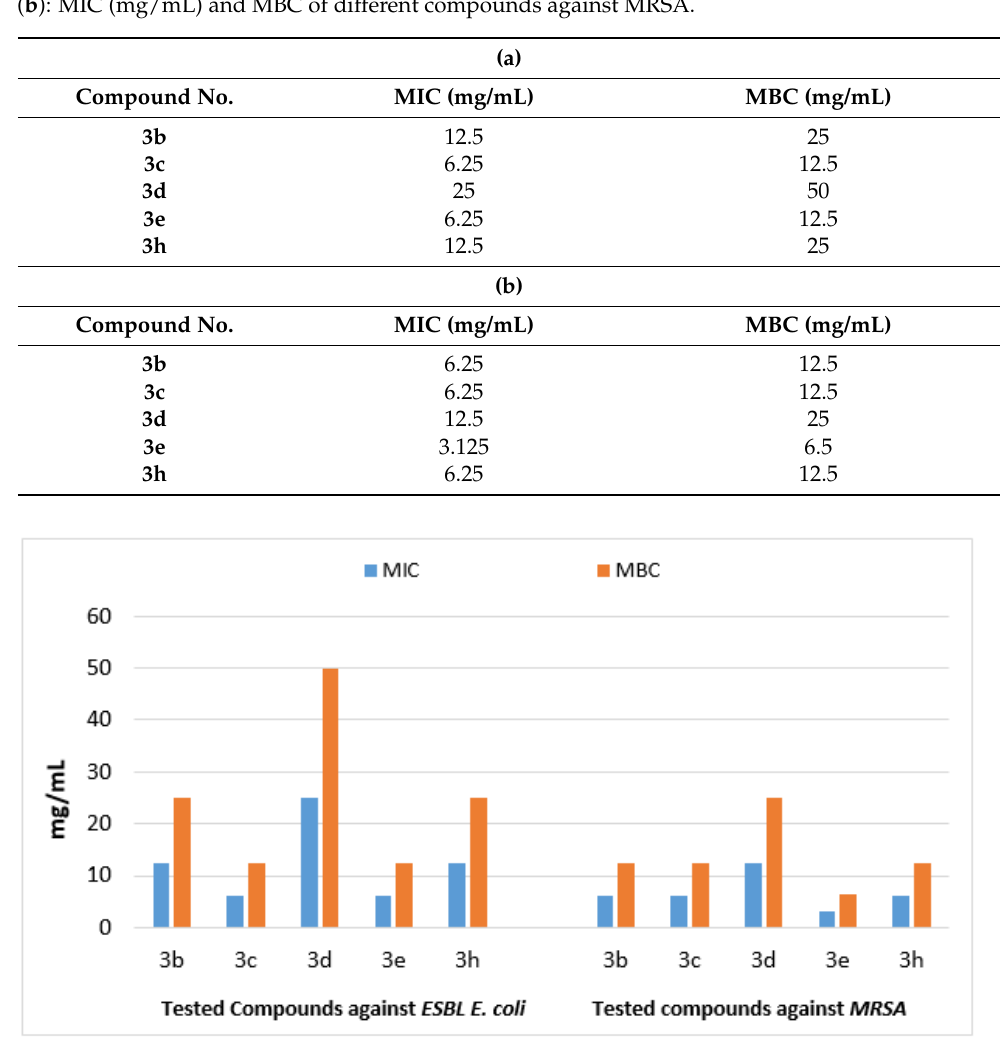
Figure 4. MIC and MBC of different compounds against ESBL E. coli and MRSA.